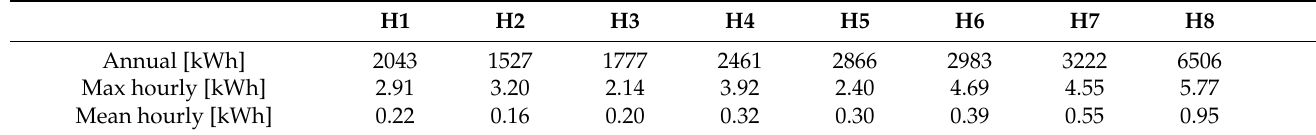
Table 4. Description of household